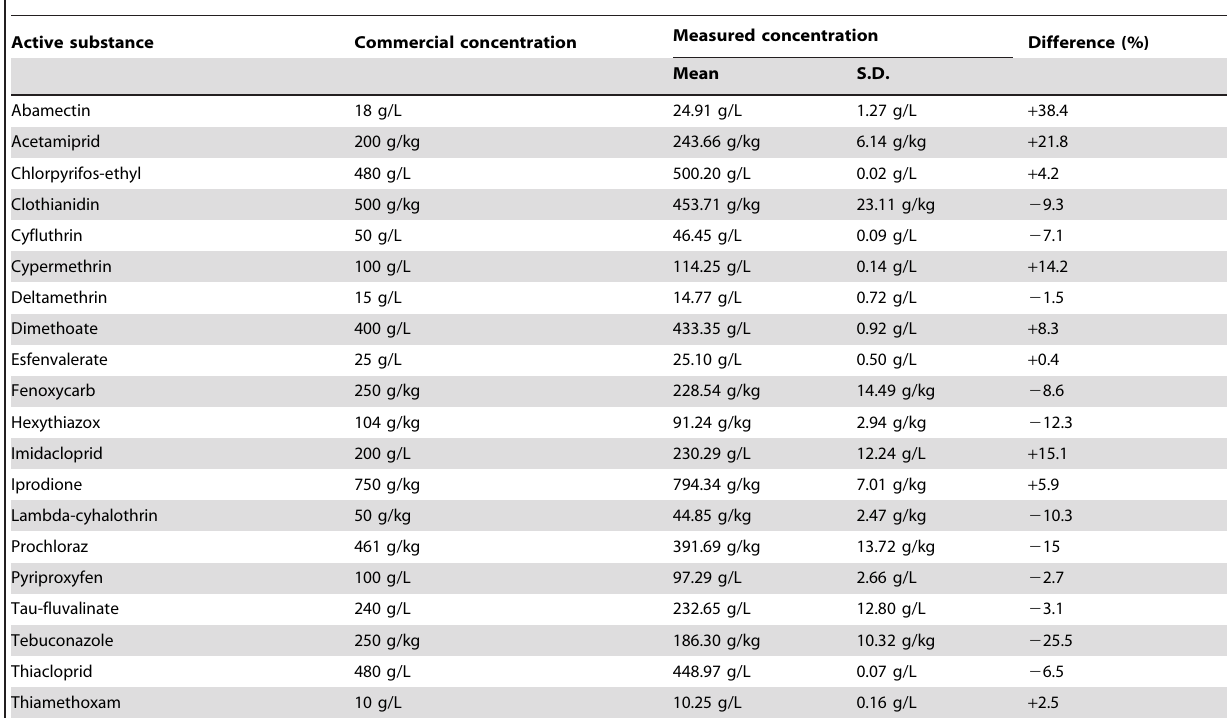
Table 2. Comparison of the commercial and measured concentrations.